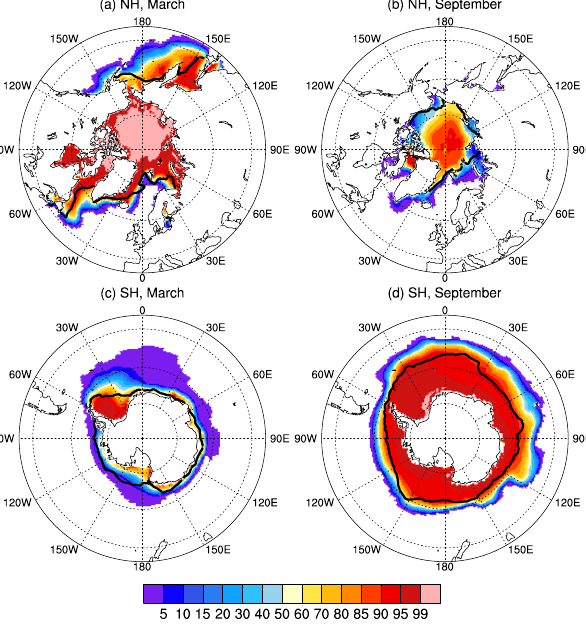
Figure 12. Mean sea ice concentration (%) over years 1976–2005 of the BNU-ESM historical run for both hemispheres and for March (a, c) and September (b, d) . The solid black lines show the 15% mean sea ice concentration from SSM/I observations (Comiso,